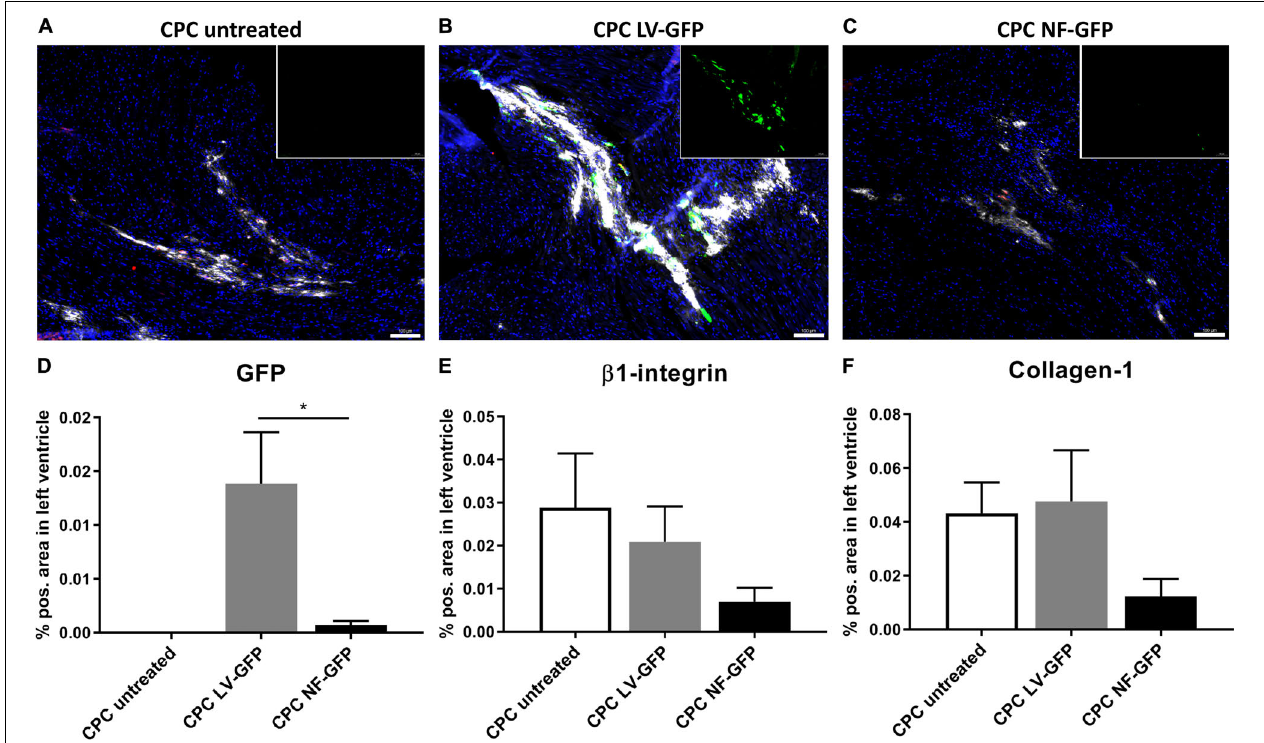
FIGURE 7 | GFP expression and CPC engraftment 1 week after transplanting CPCs to the left ventricle near the left anterior descending artery. (A–C) Typical examples of expression of GFP (green), β 1-integrin (red), and Collagen-1 (white) in mouse hearts injected with (A) unmodified CPCs, (B) LV-GFP transduced CPCs or (C) GFP nucleofected (NF) CPCs. Inset: GFP expression alone. Scale bars represent 100 µ M. (D–F) Expression of GFP, β 1-integrin, and Collagen-1 in mice injected with unmodified CPCs ( n = 4), lentivirally transduced CPCs ( n = 4) or nucleofected CPCs ( n = 5), measured as% positive area of total left ventricular area. * indicates P <